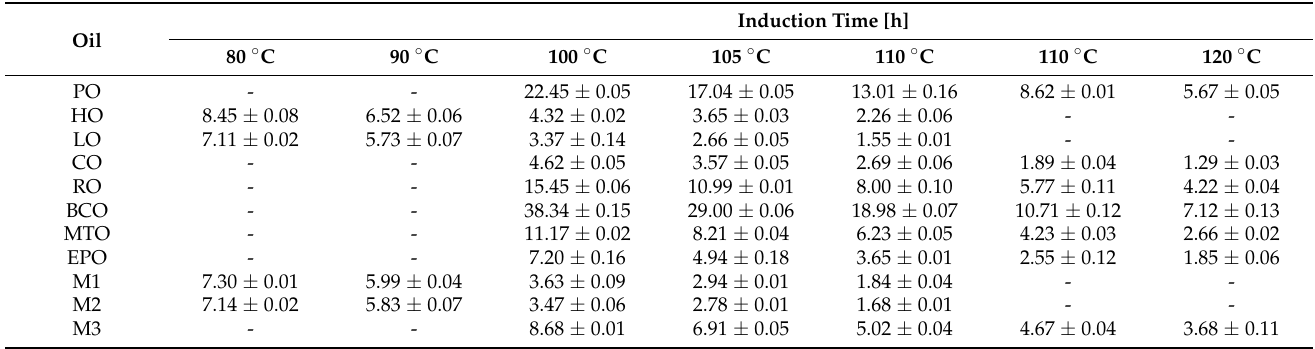
Table 4. Induction time of analysed oils at temperatures from 80 to 120 ◦